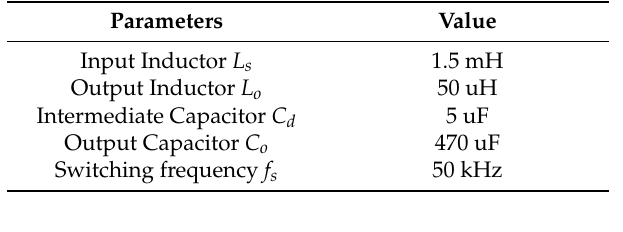
Table 2. Parameters of the bridgeless Cuk converter for simulation and experimentation.